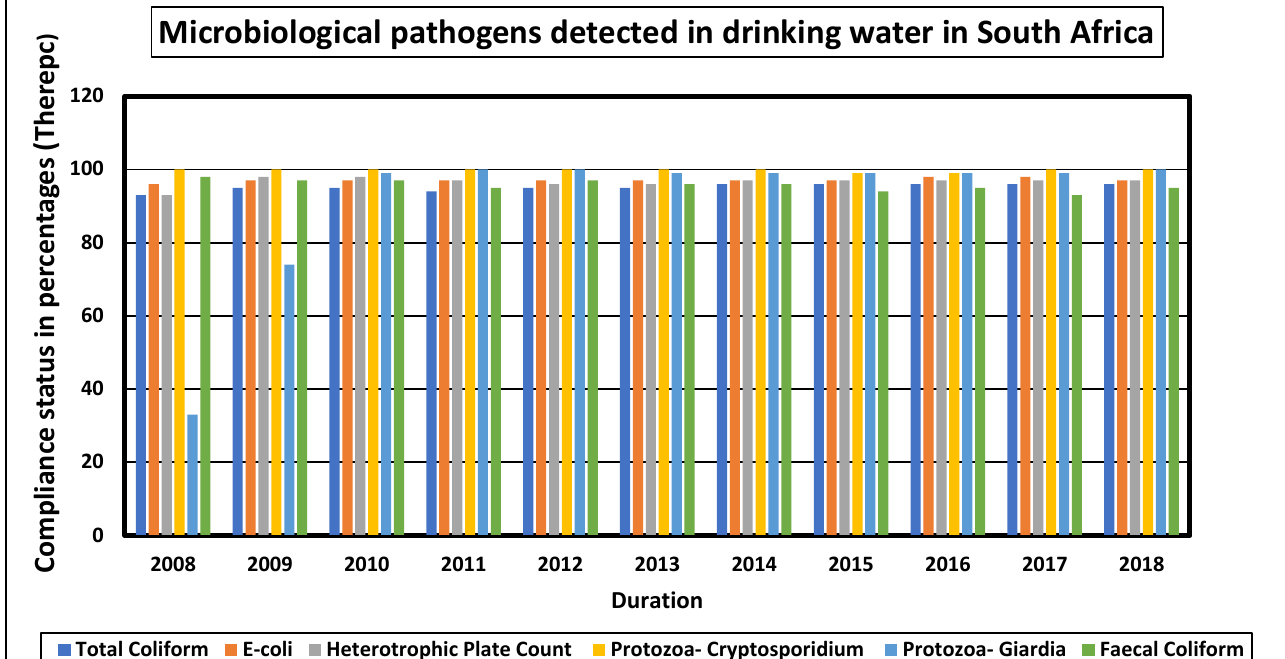
Figure 2. Microbiological pathogens detected in drinking water for all provinces in South Africa annually.